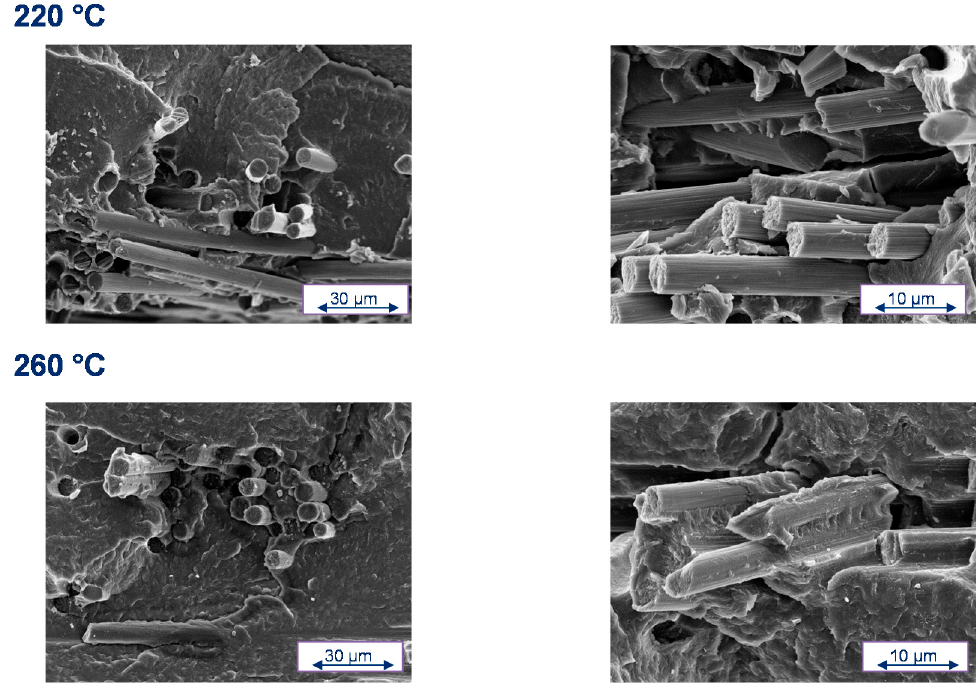
Figure 3. Microscopic images of the sizing Silastol CF1/CF2 after processing at 220 and 260 °C.